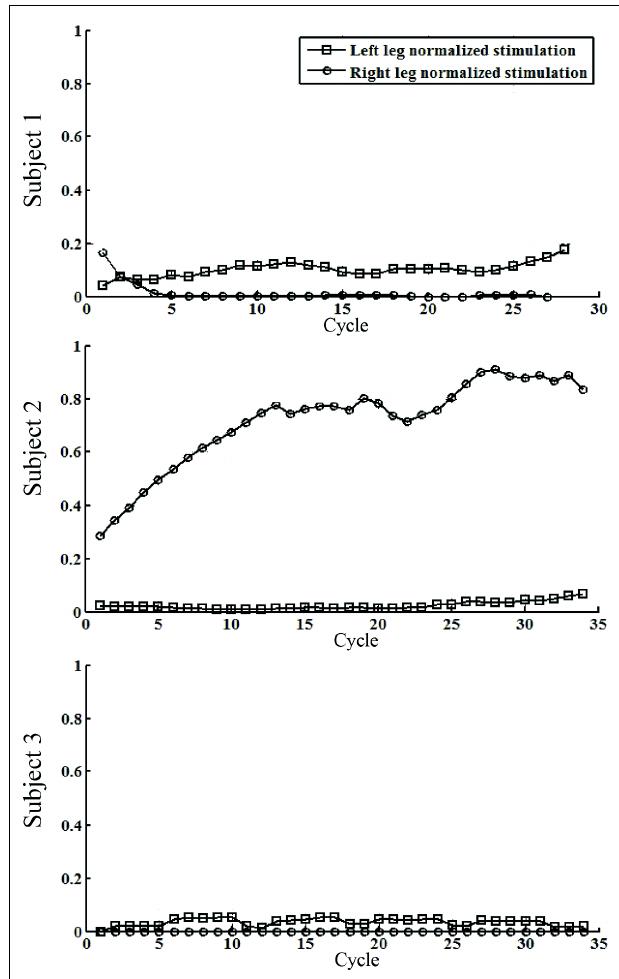
FIGURE 5 | Single-subject performance of quadriceps EMS during the walking experiment. The data represents the averaged stimulation for the knee extensor muscles during the stance phases of walking. Cycle means number of